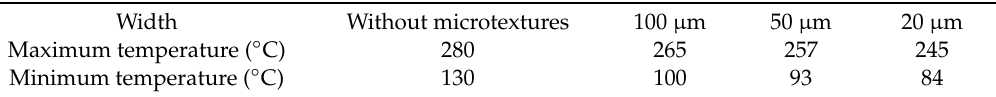
Figure 2. Temperature distributions of the cylinder ( a ) without microtextures and with microtextures at di ff erent widths: ( b ) width = 100 µ m, ( c ) width = 50 µ m, ( d ) width = 20 µ m. Table 3. Temperature results of the cylinder without microtextures and with microtextures at di ff erent